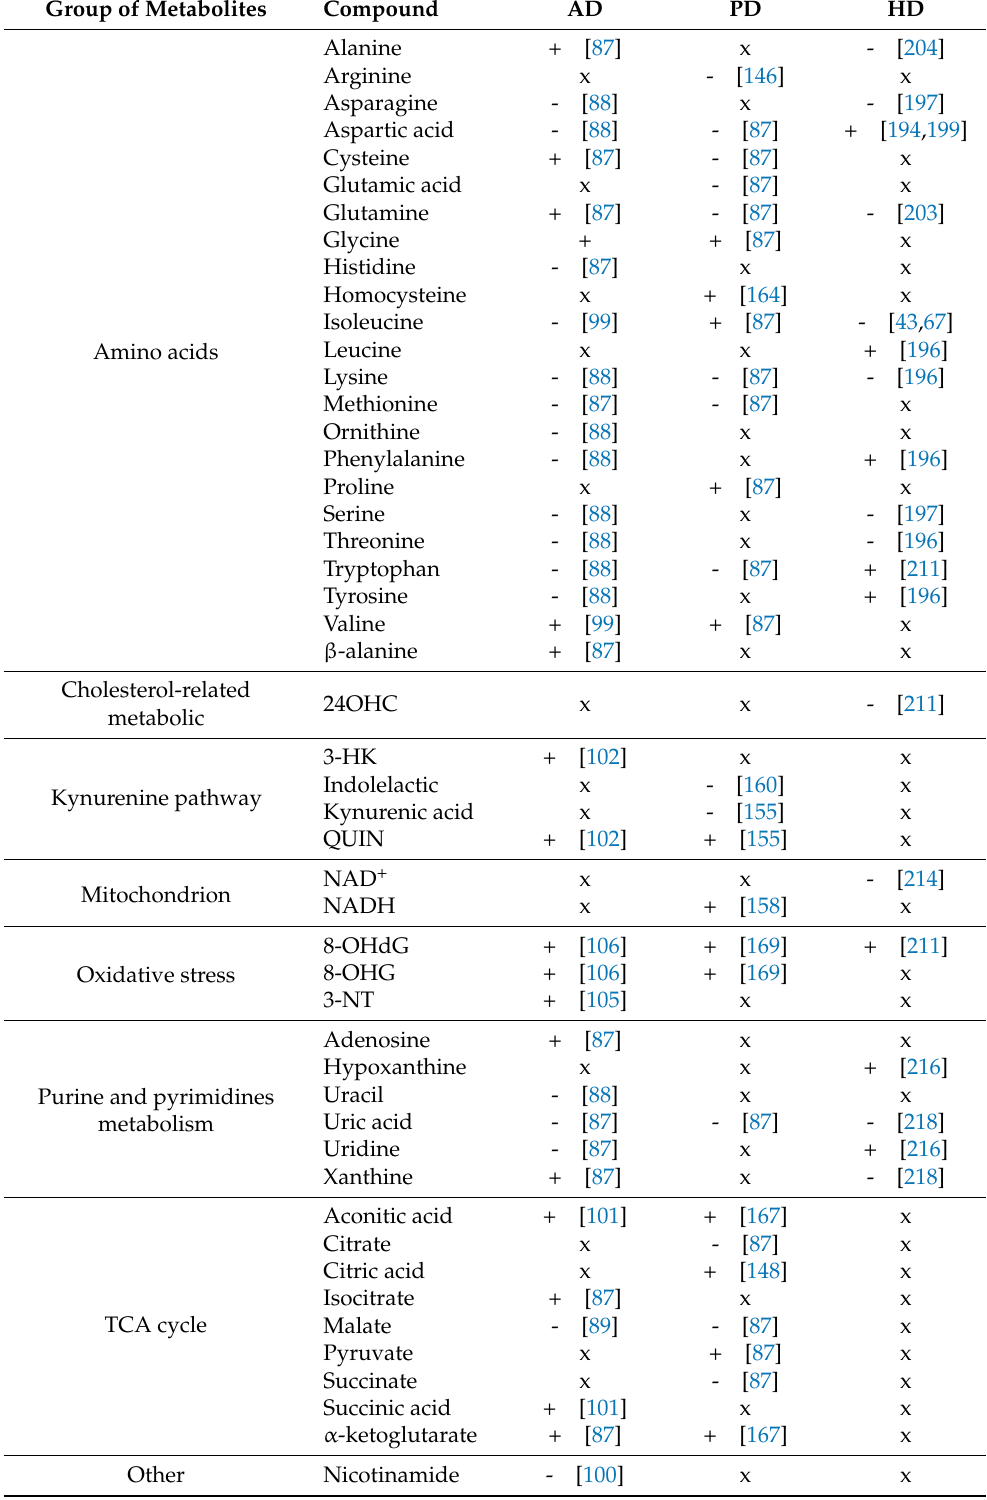
Table 1. Comparison of disturbances in concentrations of metabolites associated with impaired energy metabolism in AD, PD, and HD (+ increased level, - decrease level, x—no